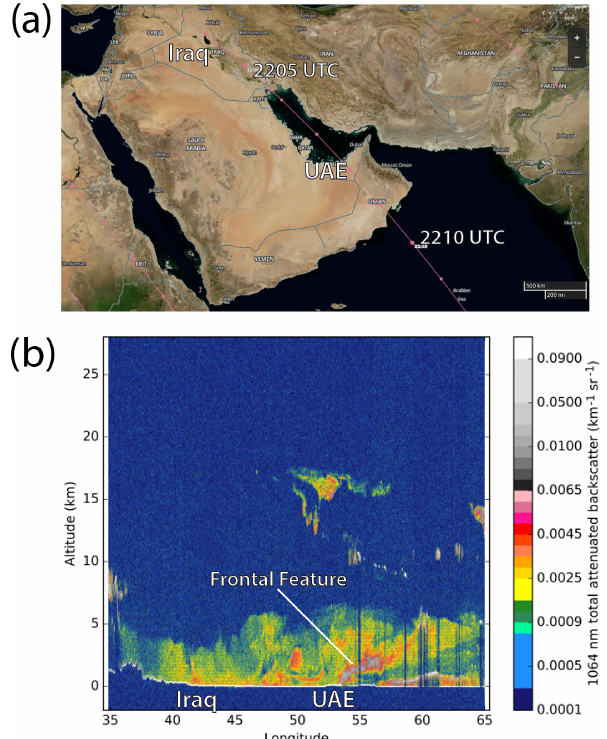
Figure 6. (a) ISS ground track (NASA Worldview) and (b) CATS 1064nm total attenuated backscatter cross section for 3 Au- gust 2016, ∼ 22:03–22:14UTC. Noted is an apparent dust frontal feature extending from the surface to 2–3km above mean sea level.